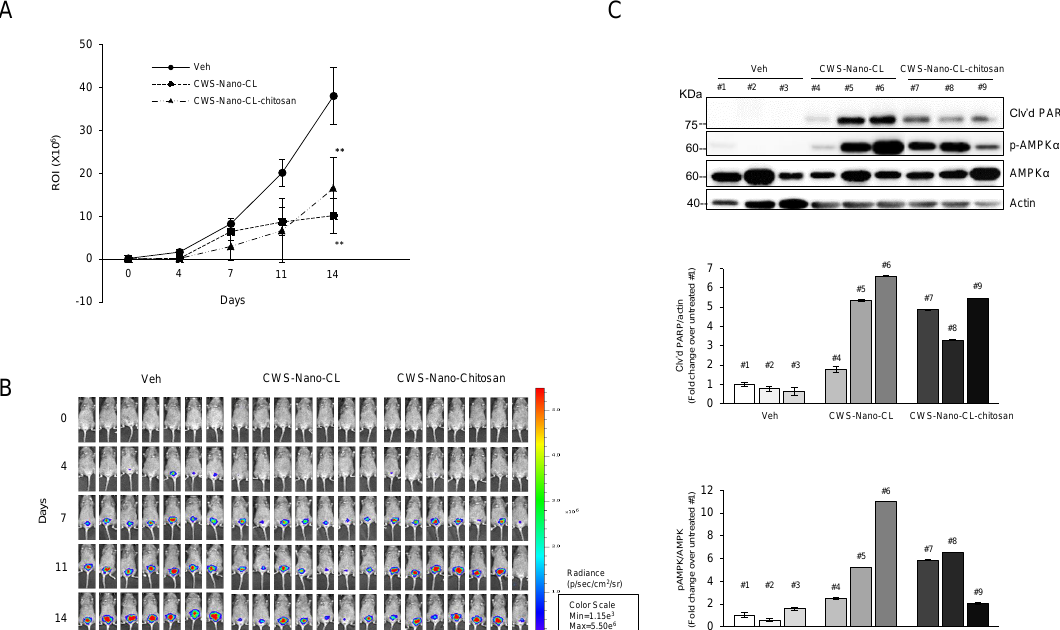
Figure 6. E ff ects of CWS-loaded formulations on tumor regression in an orthotopic bladder cancer mouse model. ( A , B ) Luciferase gene-expressing MBT2 (MBT2-Luc) cells were implanted